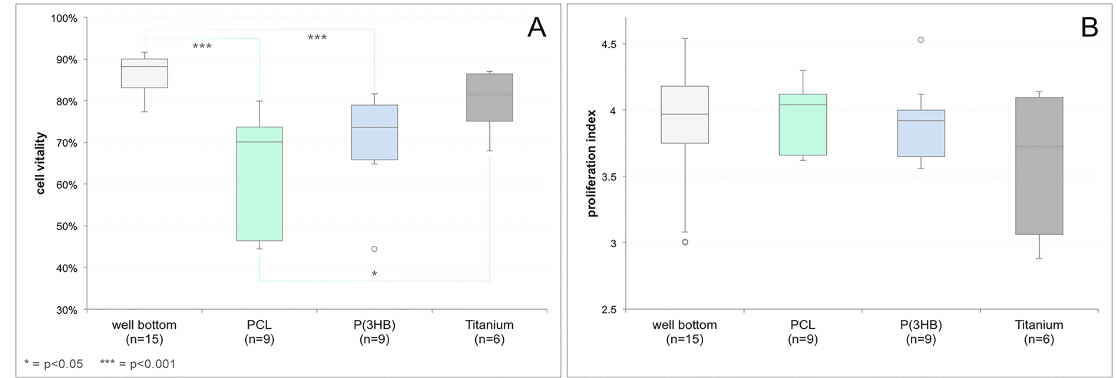
Figure 8. Vitality of green fluorescent protein (GFP)-osteoblasts on the blank well bottom (positive control), PCL and P(3HB) foils, as well as on titanium scaffolds ( A ). The Kruskall–Wallis Test followed by the Wilcoxon’s rank-sum test showed a significantly lower cell vitality on both PCL and P(3HB) compared to the well bottom. Also, significantly lower cell vitality on PCL compared to the titanium scaffolds was revealed. Proliferation index of GFP-osteoblasts on the blank well bottom (positive control), PCL and P(3HB) foils, as well as on titanium scaffolds ( B ). No significant difference between the materials could be found using the Kruskall–Wallis Test (horizontal line = median, whiskers = minimal and maximal value, circle = outlier, * = p < 0.05, *** = p < 0.001).